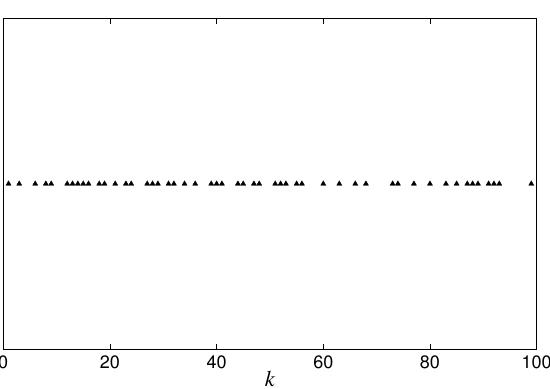
Figure 6. Switch times of the HTM.